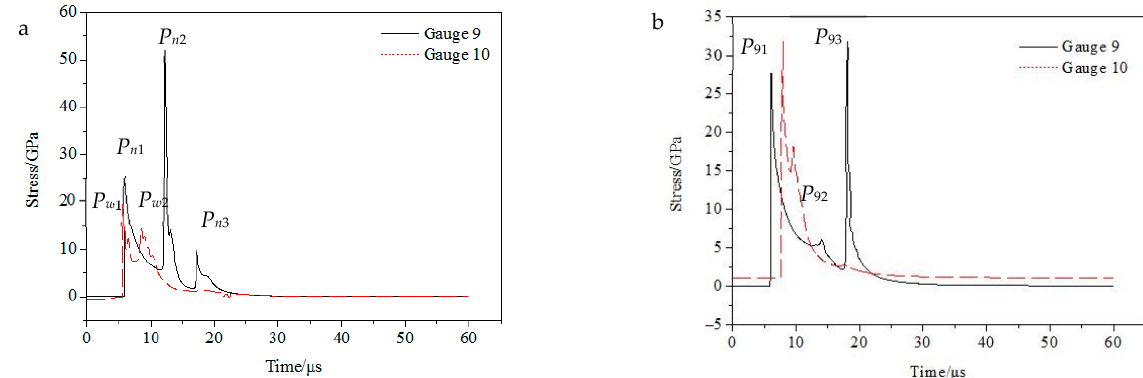
Figure 5. Burst pressure curve: ( a ) composite charge; ( b ) integrated charging.